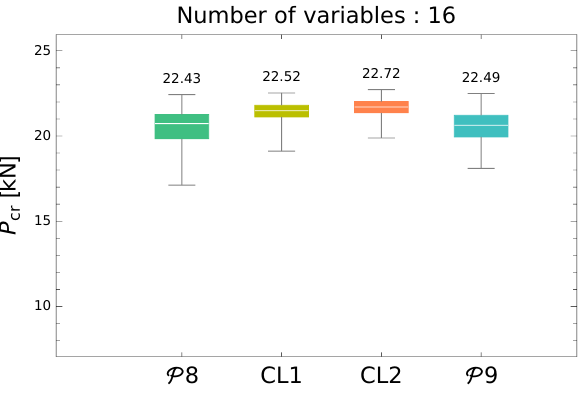
Figure 6. Maximization of P cr through GA-DNN